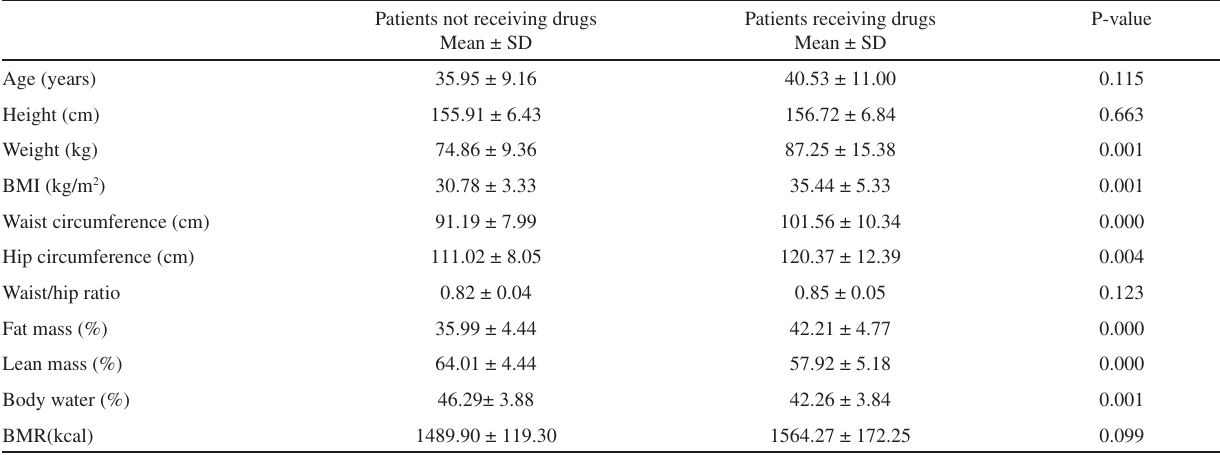
Table 1 - Anthropometric characteristics of patients receiving and not receiving drugs